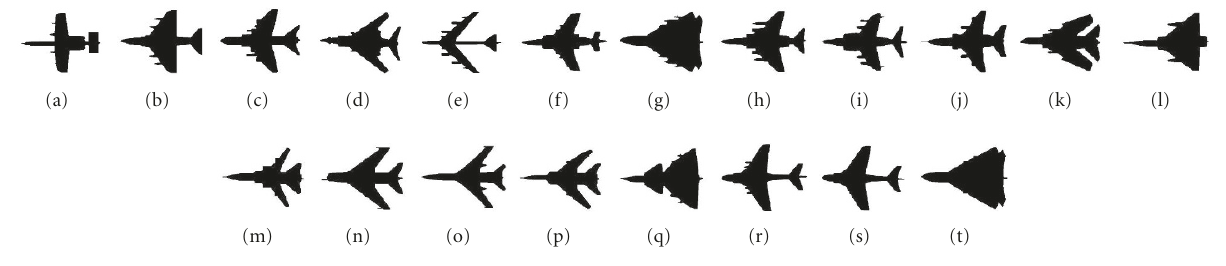
Figure 2: The database of airplane object images in their top view.